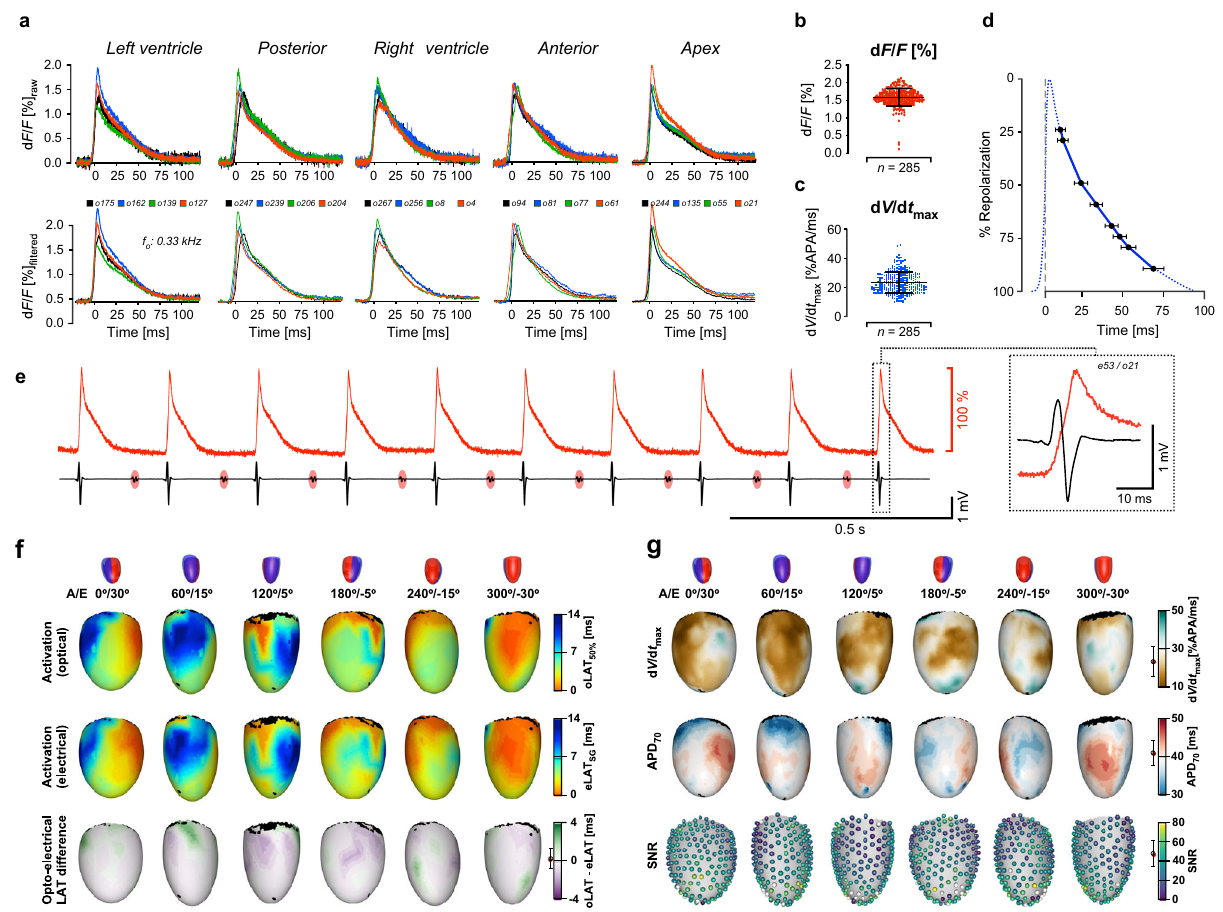
Fig. 2 Panoramic optoelectrical mapping of a di-8-ANEPPS stained C57BL/6J mouse heart in sinus rhythm. a Raw and fi ltered optical action potential (oAPs) as recorded by a selection of individual optical fi bers in contact with different regions of the heart. b Fractional fl uorescence changes (d F / F ) of oAPs. c Maximal upstroke velocities (d V /d t max ) of oAPs. d Durations of oAPs measured at different levels of repolarization (mean ± SD; n = 285). e Sequence of sinus activations measured simultaneously by a single optical fi ber (above) and an adjacent electrode (below). Large amplitude electrograms indicating local ventricular activation are preceded by small signals corresponding to atrial activation (red ovals). The last activation is shown in expanded form on the right. f Schematic of heart orientation (A: angle, E: elevation, red: left ventricle, blue: right ventricle) with corresponding 3D maps of optically (top) and electrically (center) determined ventricular activation patterns. Bottom: Difference map of optical and electrical determinations of local activation times (oLAT 50% − eLAT SG ) with mean ± SD shown on the left of the color bar ( n = 64). g 3D maps of the spatial distribution of d V /d t max (top), action potential duration at 70% repolarization (APD 70 ; center) and signal-to-noise ratios (SNRs) of oAPs recorded during a single activation with spheres indicating the recording sites. Parameter statistics (mean ± SD) are shown on the left of the color bars ( n = 285 each). “ n “ refers to the number of signals produced by the recording sites during a single activation of the heart. Error bars refer to ±SD. Source data are provided as a Source Data fi